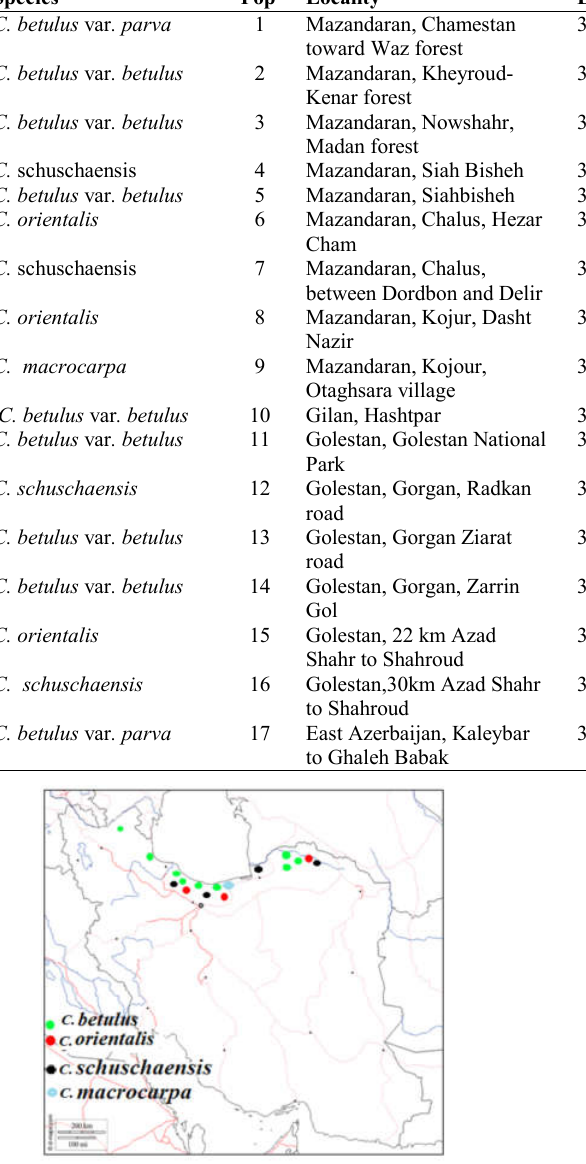
Fig. 1. Distribution map of the Carpinus populations